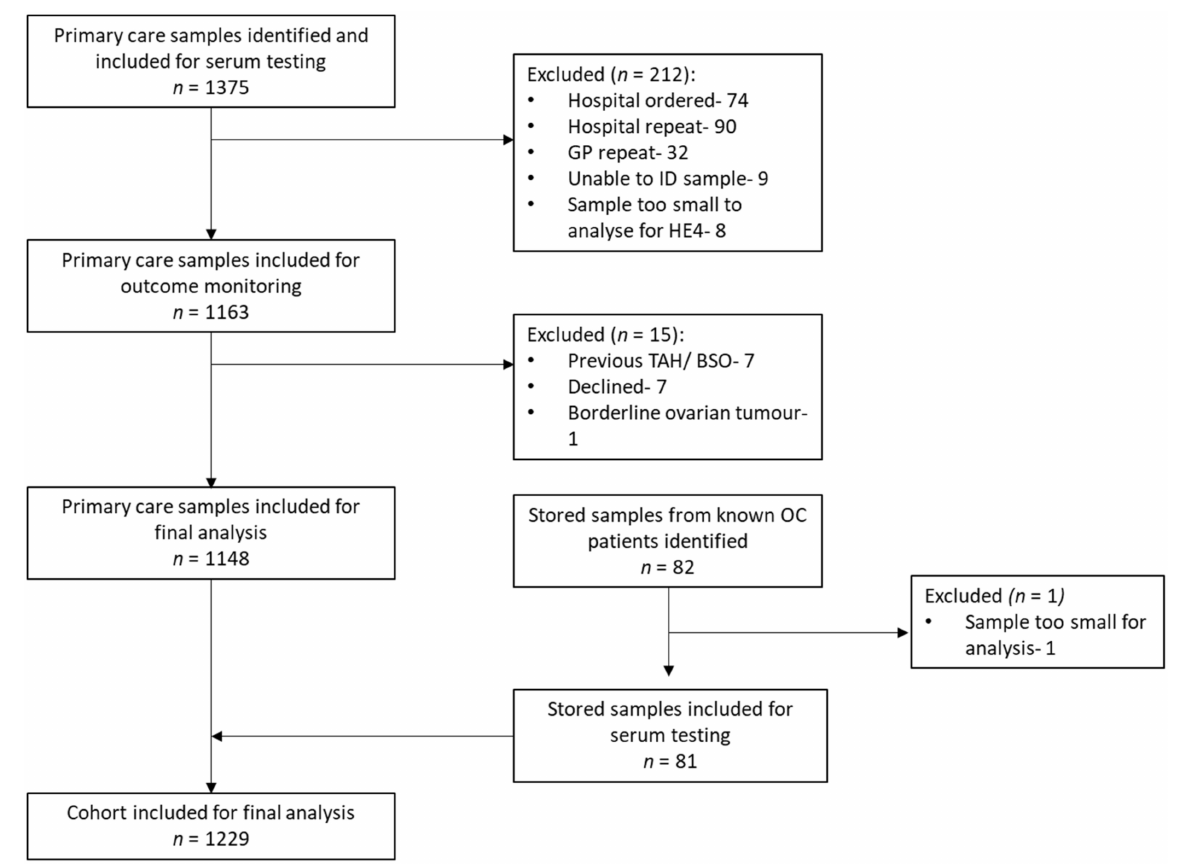
Figure 2. Study schema. The mean age of the whole group was 50 years (SD 15.7). Regardless of age, the women with ovarian cancer demonstrated significantly higher levels of CA125 (under 50 years: 14 vs. 167 U/mL ( p < 0.001) and over 50 years: 11 vs. 257 U/mL ( p < 0.001)) and HE4 (under 50 years: 53 vs. 284 pmol/L ( p < 0.001) and over 50 years: 68 vs. 314 pmol/L ( p < 0.001)), respectively (Table 1). In women without ovarian cancer, serum CA125 was significantly higher in those under 50 years (14 vs. 11 U/mL ( p < 0.001)), whereas serum HE4 was significantly higher in women over 50 years (52 vs. 68 pmol/L ( p < 0.001)). A total of 36% (190/525) of women without ovarian cancer over 50 years of age had an isolated raised serum HE4 compared to only 11% (65/622) of those under 50 years, suggesting age impacts serum HE4 levels. Serum HE4 was raised in isolation more frequently than serum CA125 regardless of age (22% (255/1147) vs. 5%